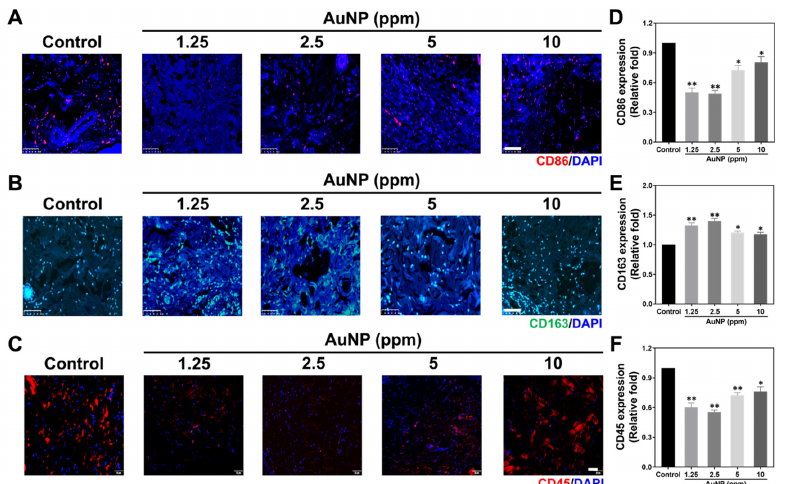
Figure 11. Evaluation of anti-inflammatory abilities in rat models with AuNP treatments for 4 weeks via IHC staining assay. The images of ( A ) CD86 marker expression (M1 macrophage polarization, red) and ( B ) CD163 marker expression (M2 polarization, green) are displayed. The scale bars were set at 100 μ m. ( C ) The CD45 marker expression (red fluorescence) is presented as the leukocyte filtration influenced by AuNP treatments. The scale bar was measured as 50 μ m. The ( D ) CD86 and ( E ) The CD163 macrophage marker’s expression intensity was semi-quantified. ( F ) The semi-quantified data of CD45 marker expression intensity. The results demonstrate that 1.25 and 2.5 ppm AuNP treatments have good biocompatibility in an animal model. The data are demonstrated as mean ± SD ( n = 3). * p < 0.05, ** p < 0.01: compared to the Control group (TCPS).